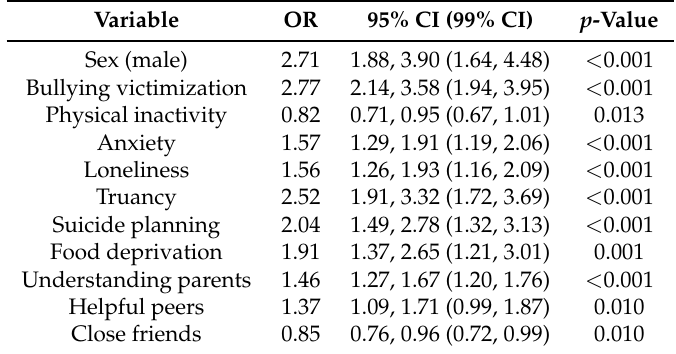
Table 4. Multivariable analysis of physical fighting among school-attending adolescents in Kuwait, GSHS 2015.